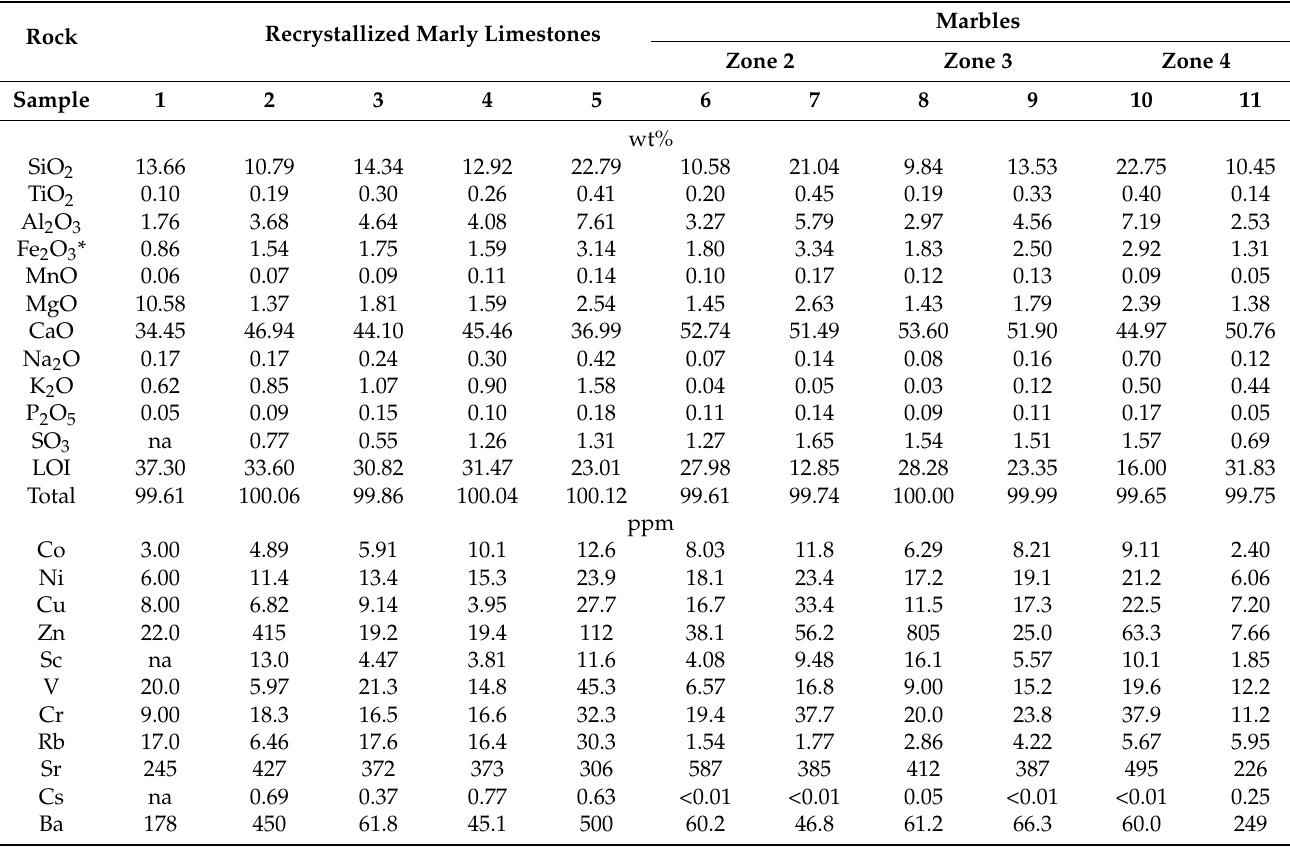
Table 3. Major (in wt%) and trace element compositions (in ppm) of recrystallized marly limestones and marbles from the Kochumdek contact aureole (representative samples) compared with Post-Archean limestone. Rock Recrystallized Marly Limestones